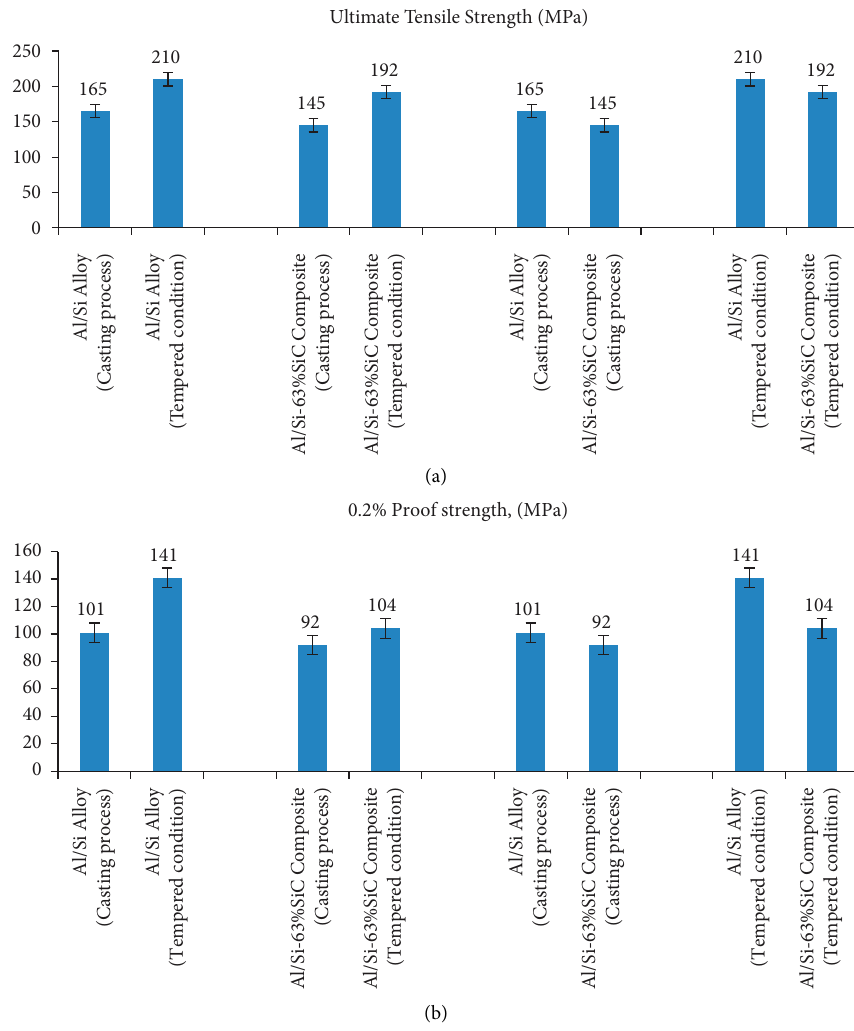
Figure 5: (a) UTS of test case specimens (b) 0.25% of proof stress observations.